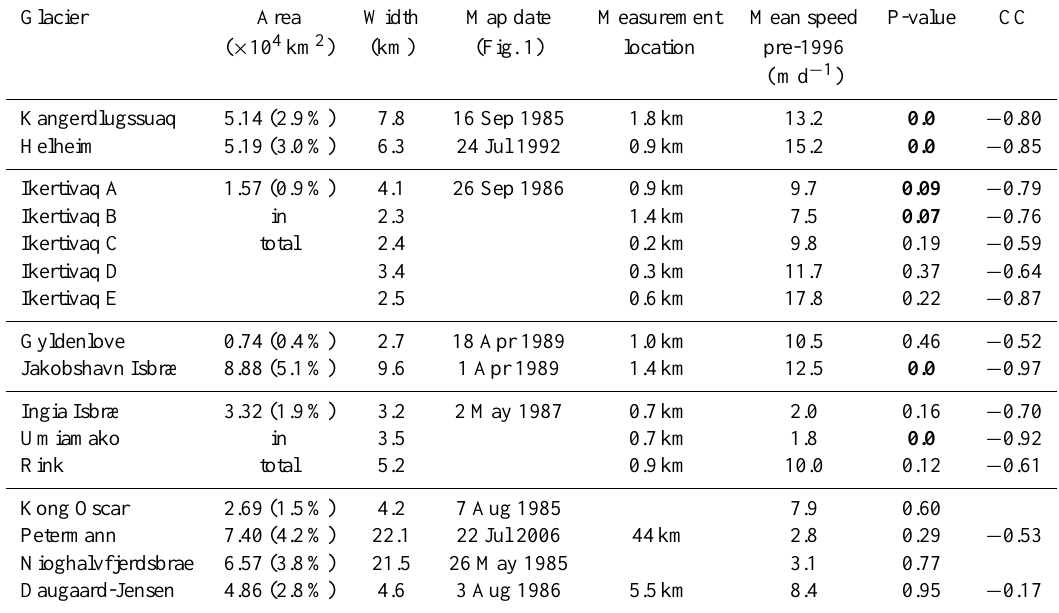
Table 1. Glacier outlet catchment areas, widths and locations for speed measurements (behind the most retreated frontal position). P-values are based on a Levene test for the null hypothesis that there is no difference in flow speed variance before and after 1995; values less than 0.1 are in bold. The correlation coefficient (CC) is that between speed and frontal position over the full time series. No CC for Kong Oscar or Nioghalvfjerdsbrae because fronts were not digitised for some or any of the velocity measurements. Glacier